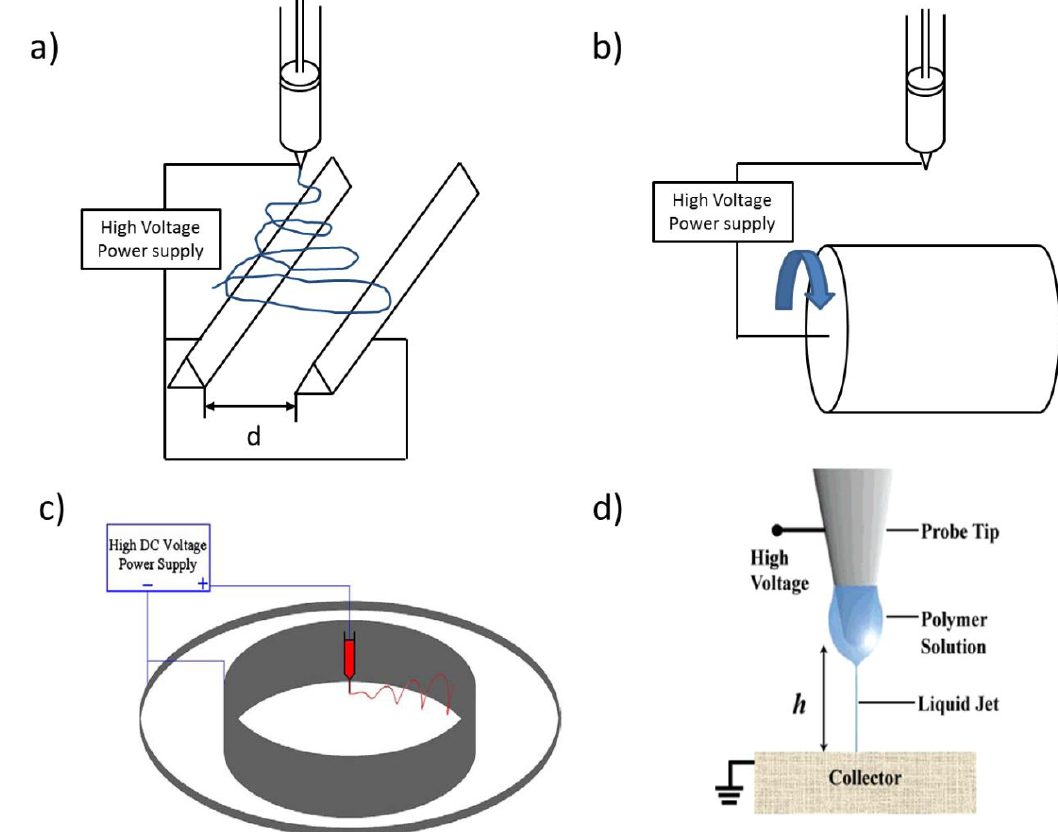
( b ) rotating collector; ( c ) rotating jet method and ( d ) near field electrospinning. Adapted with permission from [40]. Copyright (2011) by Elsevier. Adapted with permission from [56]. Copyright (2006) by American Chemical